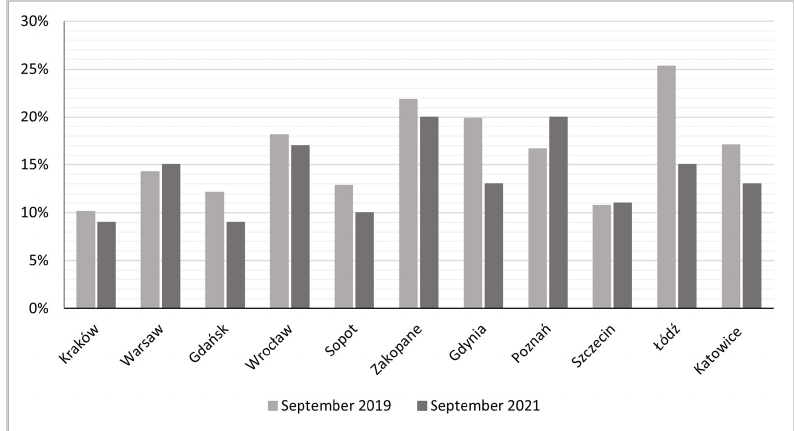
Figure 11. Shares of private rooms in total Airbnb and Vrbo active rentals.